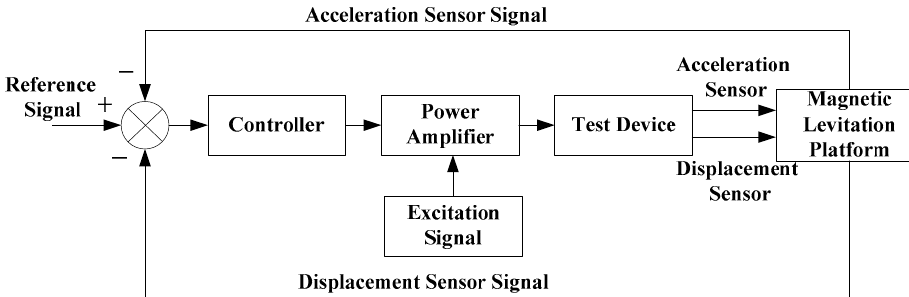
Figure 14. The schematic block diagram of the system.